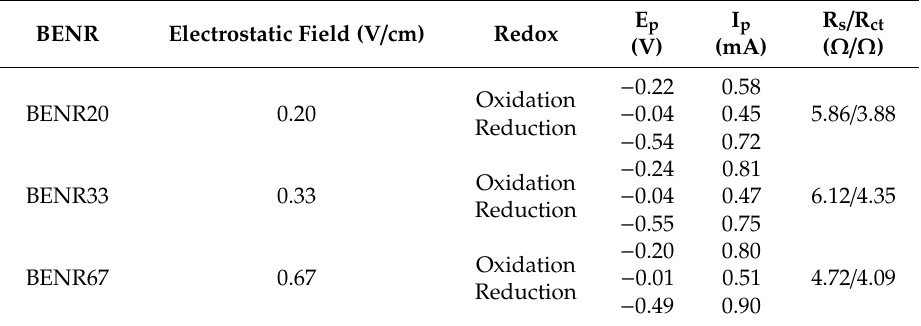
Table 2. Electrochemical characteristics of the bulk solution depending on the electrostatic field strength in the bioelectrochemical nitrogen removal reactor.